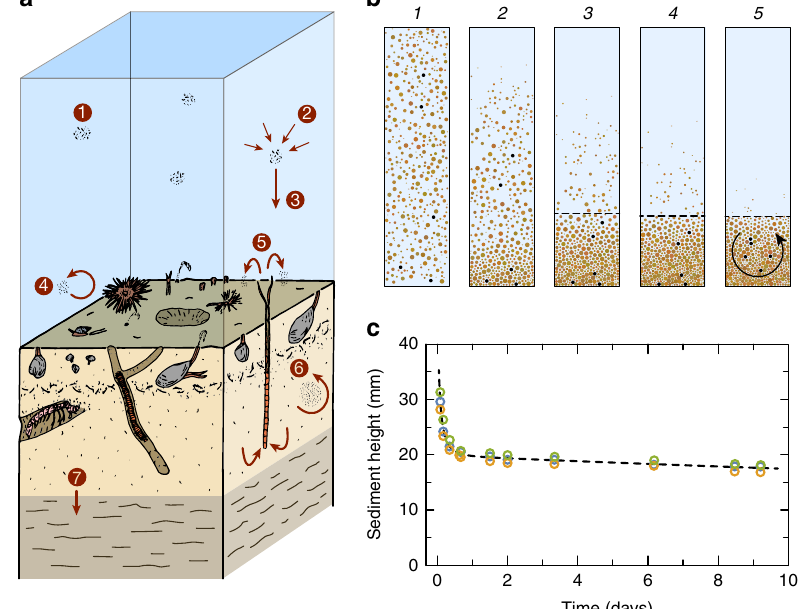
Figure 1 | Magnetization acquisition of sediment in nature and in the laboratory. ( a ) Schematic representation of natural processes affecting sedimentary magnetizations (modified from ref. 15). 1: Marine snow, 2: flocculation, 3: settling, 4: sediment resuspension, 5: non-local mixing, for example, by polychaete worms, 6: local (diffusive) sediment mixing leading to particle reorientation and 7: burial in the consolidating layer. ( b ) Schematic representation of sediment redeposition in five different time frames. A homogeneous sediment suspension settles in a magnetic field forming a clear sediment–water interface (dashed line) after some time. The same five particles are highlighted by black dots in each frame. A DRM is acquired by the alignment of magnetized particles in the ambient field during deposition (frames 1–4). This magnetization is stabilized by inter-particle forces developing at contact points (frames 3–4). Sediment mixing (arrow in frame 5) is responsible for particle realignment after deposition and generates a PDRM. Only local (diffusive) sediment mixing is produced in our experiments. ( c ) Height of the sediment–water interface (dots), for three redeposition experiments. The dashed line is a guide for the eye. A nearly stable interface is obtained within the first